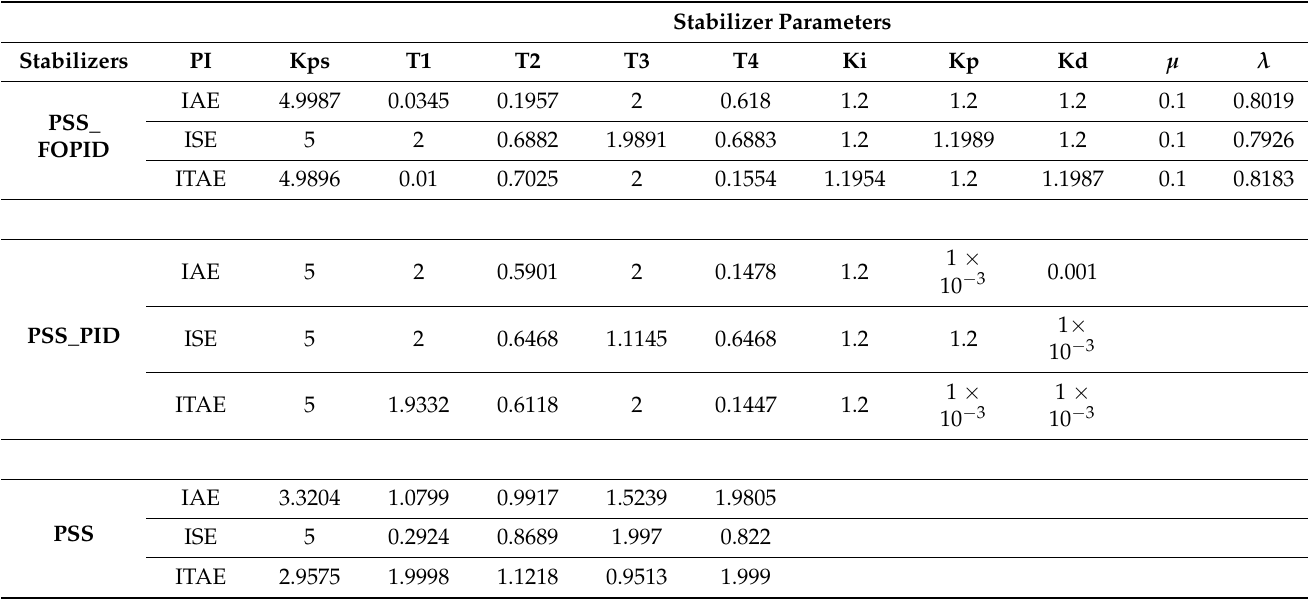
Table 3. Optimal stabilizer parameters based on the proposed WCMFO.